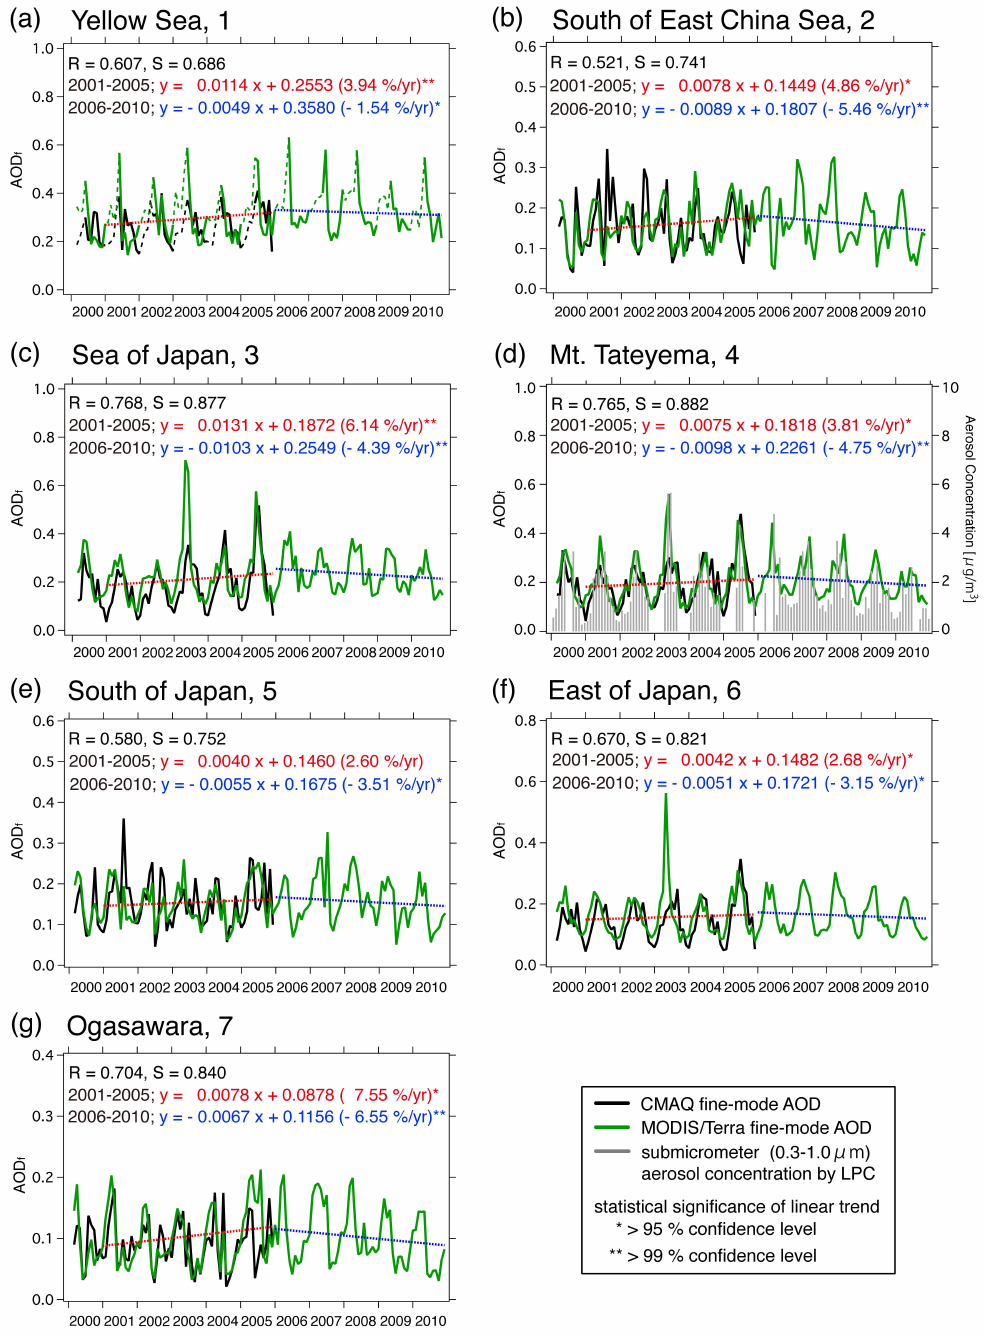
Fig. 3. Temporal variation in the monthly averaged AODf (black, CMAQ; green, MODIS/Terra) between 2000 and 2010 for the (a) Yellow Sea, (b) South of the East China Sea, (c) Sea of Japan, (d) Mt. Tateyama, (e) South of Japan, (f) East of Japan, and (g) Ogasawara, which are defined in Fig. 1. For Mt. Tateyama, the ground observation data obtained by LPC are also shown (gray bars). R and S represent the correlation coefficient and skill score between MODIS/Terra and CMAQ, respectively, and the dashed lines represent the linear tendencies of the annual mean AODf (2001–2005 and 2006–2010), excluding 2003 (and also excluding springtime for Yellow Sea) based on MODIS/Terra. The linear regression results are shown in each figure. The relative trends are calculated with average AODf during 2001–2005 and 2006– 2010 as reference years. The significance of these trends based on the 3-yr moving average is indicated for > 95% and > 99% confidence